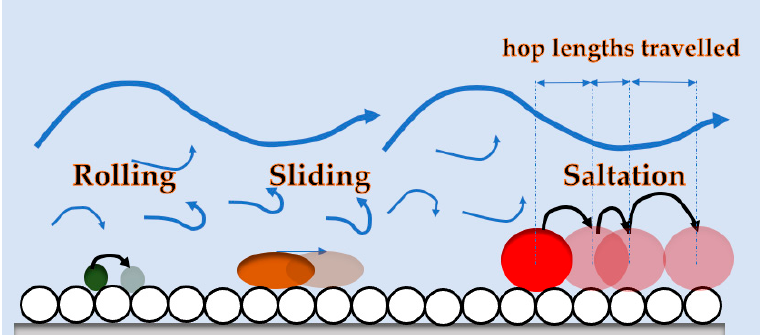
Figure 1. Schematic demonstrating the main modes of bed load transport by rolling, sliding, and saltation, shown in green, orange, and red colors, respectively. The initial resting position is shown with a dark colored particle, while the transported particle position is illustrated with the lighter respective colors. Note the variable hop distances traveled downstream by a saltating particle, as governed by highly dynamical complex three-way (particle-turbulent flow-bed surface) interactions.